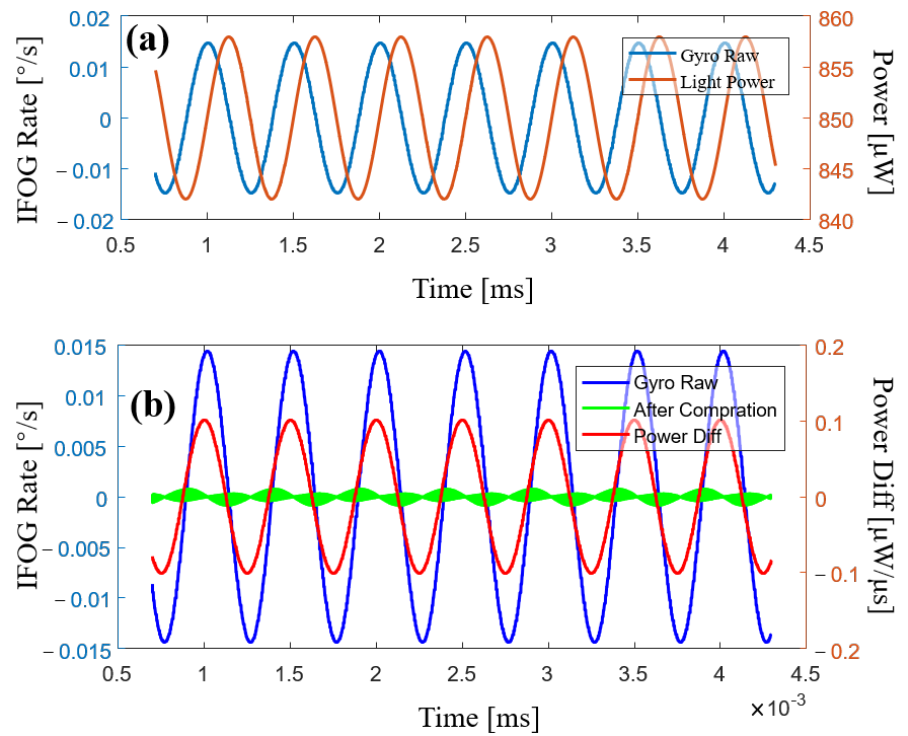
Figure 4. Simulation results of error compensation. ( a ) The blue curve is the original output of the gyroscope and the red curve is the SLD power signal. ( b ) The blue curve is the original output signal of the gyroscope, the green curve is the output of the gyroscope with compensation, and the red curve corresponds to the laser-power differential signal.